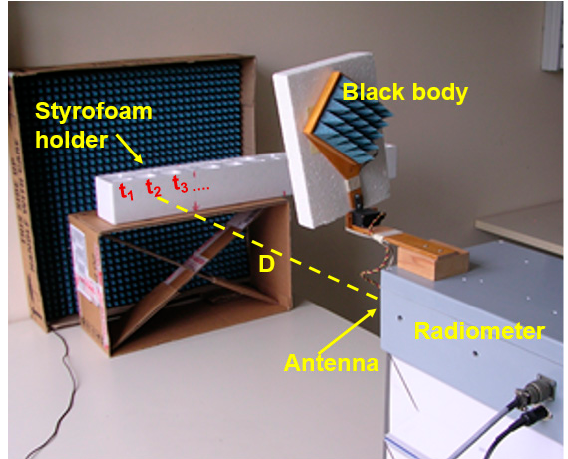
Figure 5. Experimental test setup. The radiometer antenna is placed at a distance D from the target; antenna-target position determines a normal incidence; a styrofoam sample holder was utilized to contain water and oil warmed up; t 1 , t 2 , t 3 , … are the sample holder bins sequentially filled up with water or oil, as described in Section 4.2.